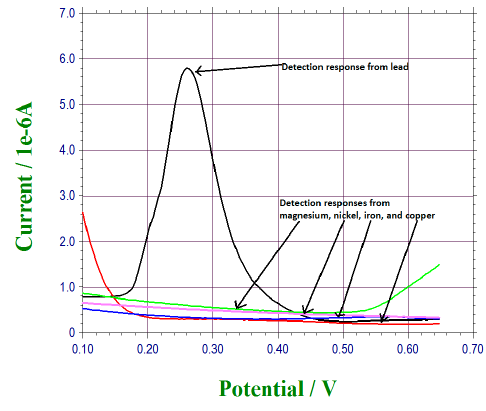
Figure 8. Interference test for the bismuth sensor.